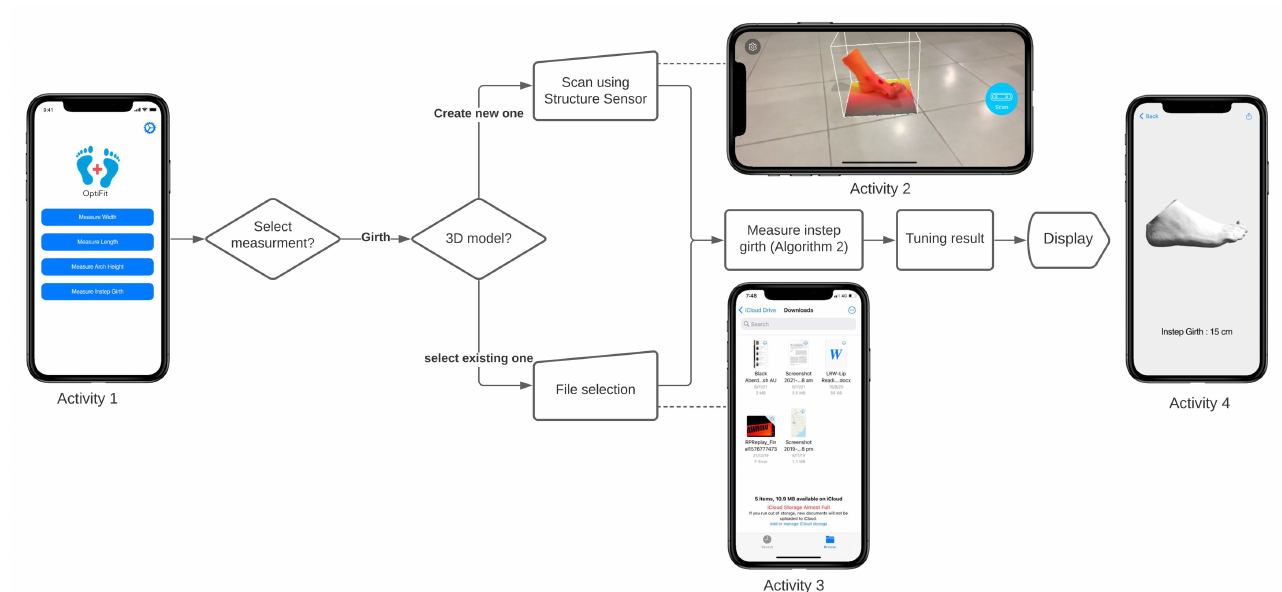
Figure 6. Activity diagram for the instep girth measurement.